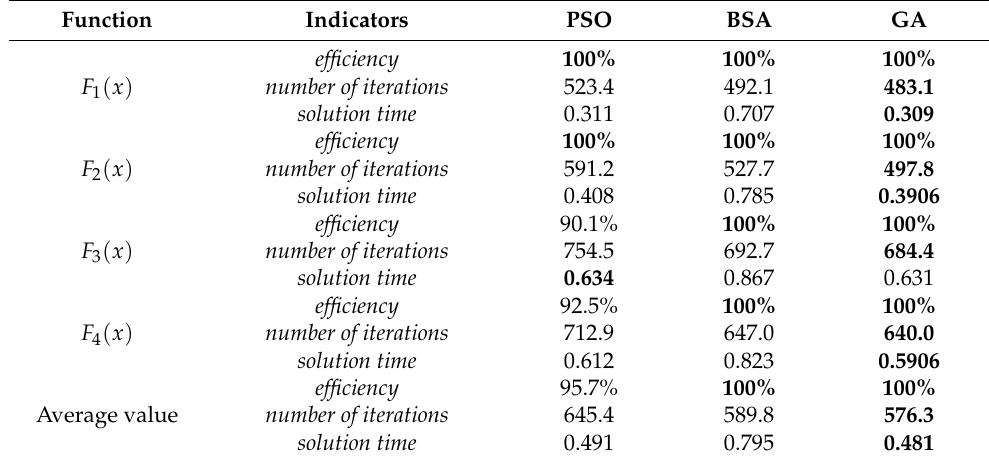
Table 4. Indicators of effectiveness of various